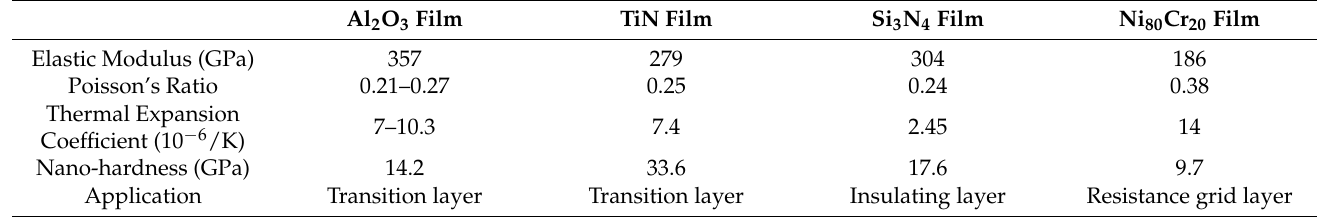
Table 2. Material properties and application of various types of films.